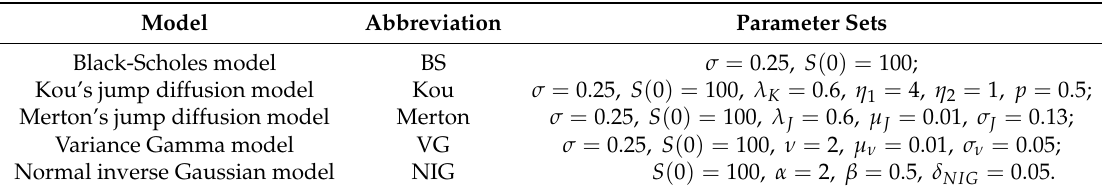
Table 1. Parameter setting for the log-asset process X